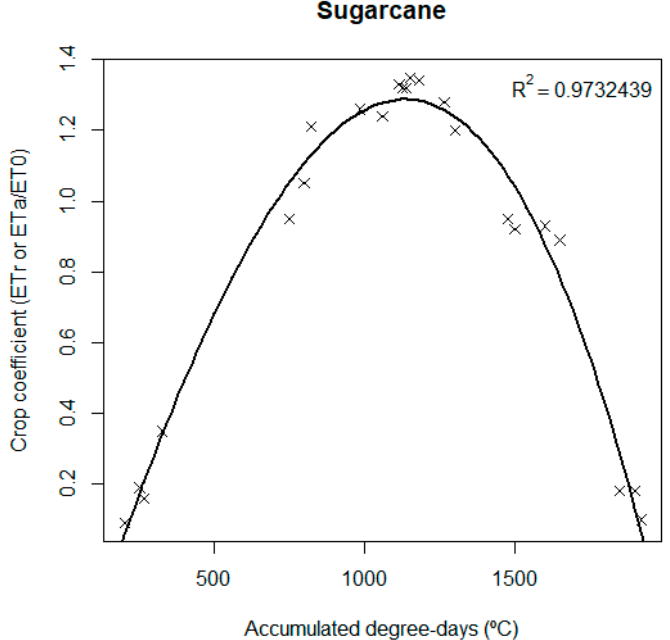
Figure 10. Variation of the mean values of the crop coefficient ( ET r ) with the accumulated degree-days ( DDac ) in the sugarcane crops of watersheds in the municipality of Águas de Santa Bárbara, the central-western part of São Paulo State, Brazil. A basal temperature of 18 °C was considered, following Doorenbos, Kassan (1979).